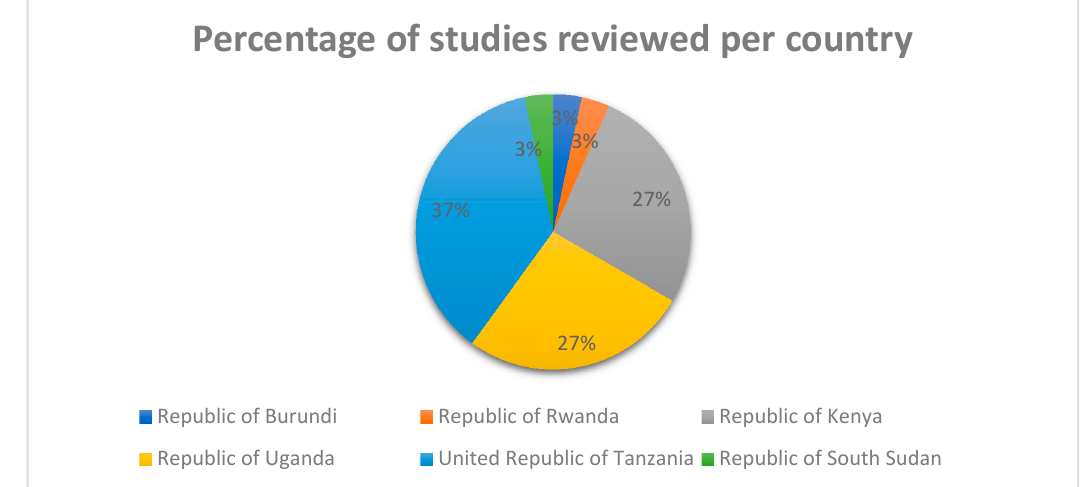
Figure 2. Percentage of studies represented in this review per EAC country.